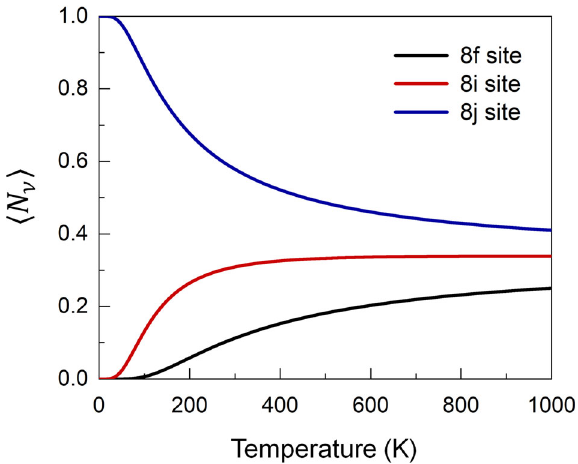
Fig. 4 Temperature-dependent occupation probability. Occupa- tion probability N ν h i of the Al substitution sites ( ν = 8f, 8i, and 8j) at an elevated temperature in SmFe 10 Al 2